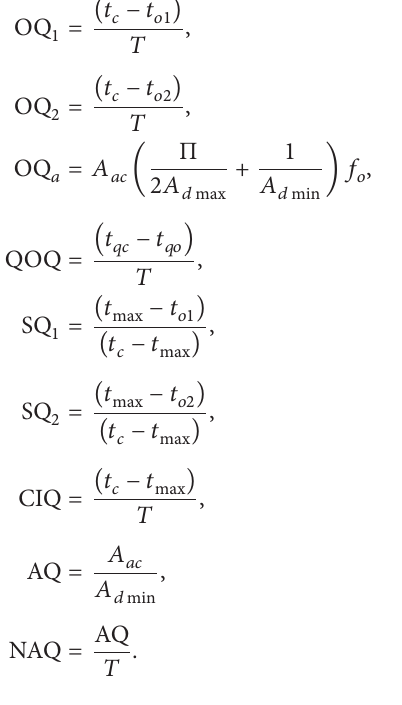
Figure 4: Time and amplitude instants in glottal pulse (a) and its derivative pulse (b)